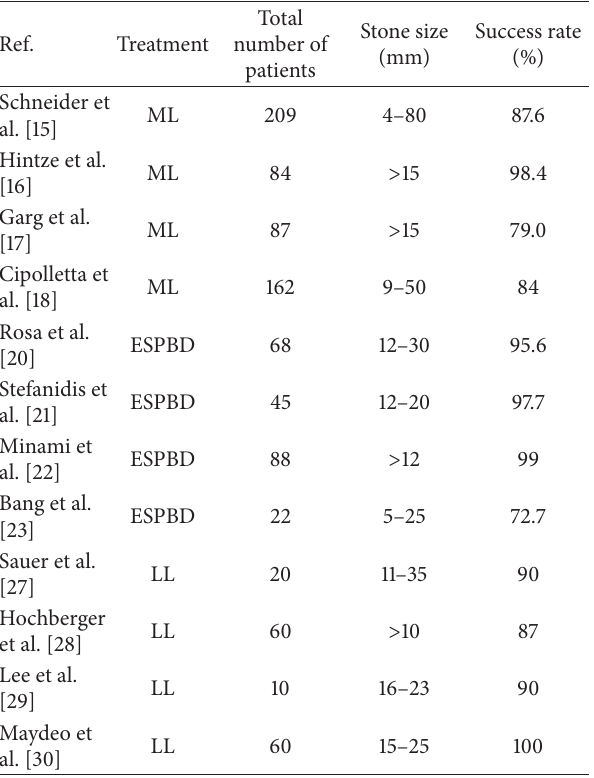
Table 4: Published cases of papillary balloon dilation, mechanical lithotripsy, and laser lithotripsy for difficult bile duct stones.